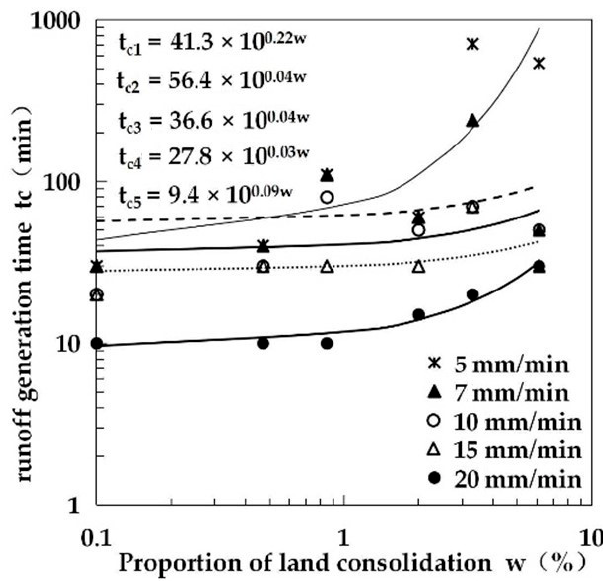
Figure 20. Changes in flow and sediment content after high-level watershed control.